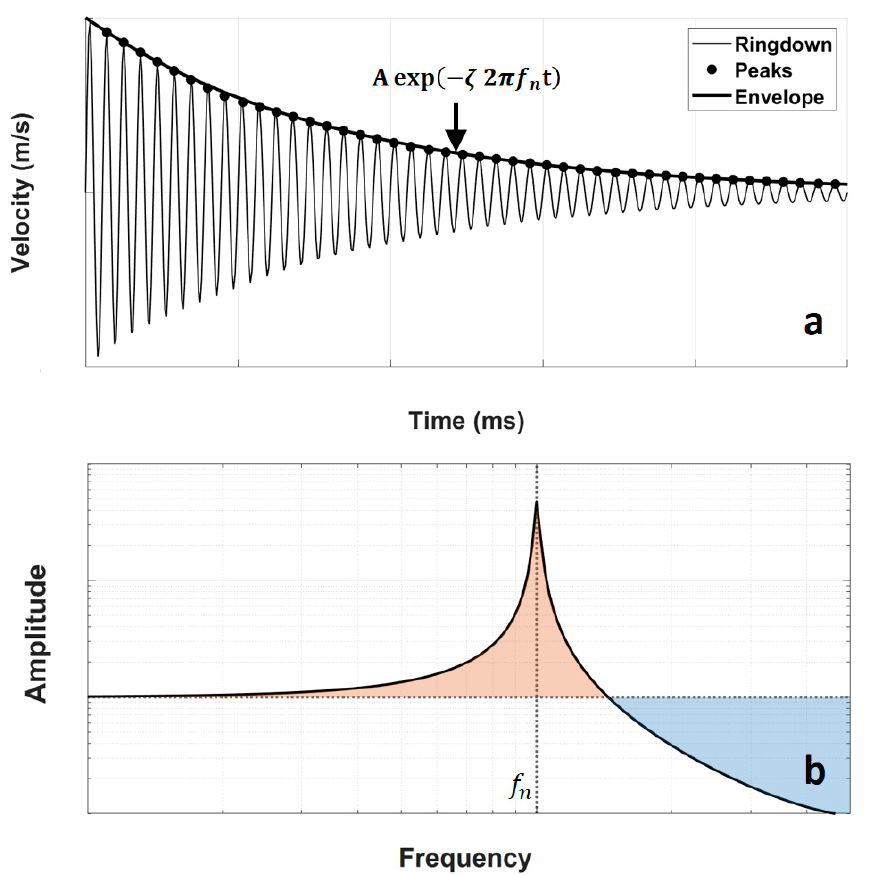
Figure A2. A representative vibration response from the cantilever specimen showing: ( a ) the ringdown plot with its envelope curve and ( b ) the frequency-domain plot of the specimen.